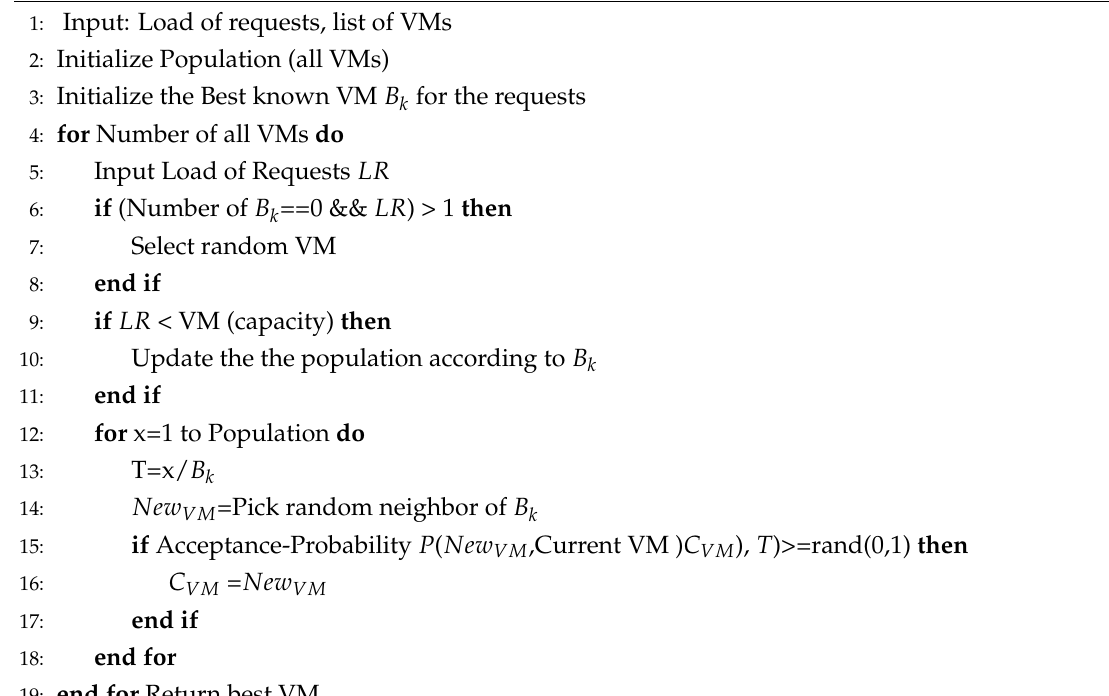
Algorithm 4 PSO-SA-based resource